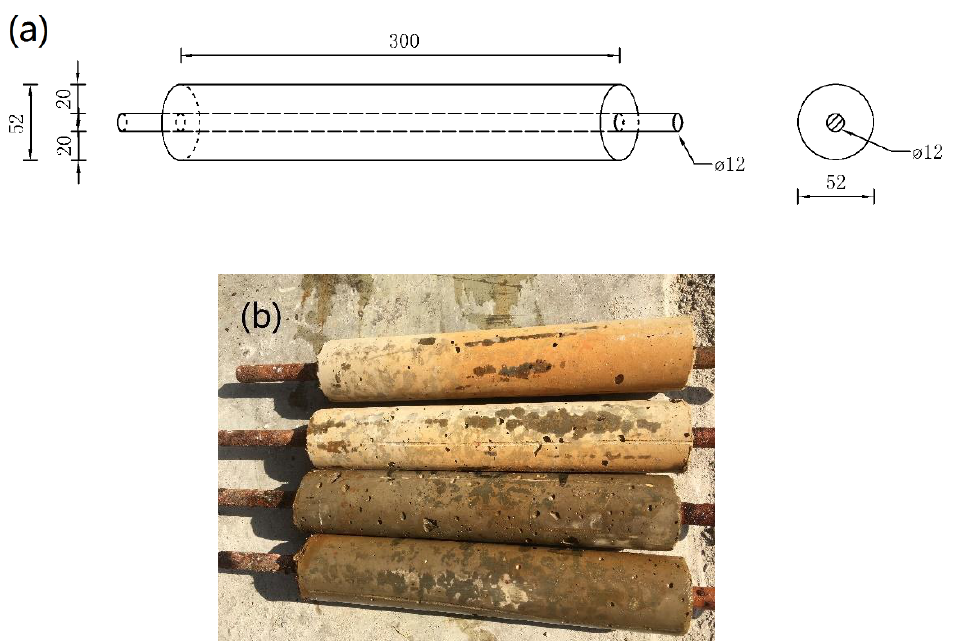
Figure 1. Details of test specimen; ( a ) Schematic diagram, ( b ) Photograph.